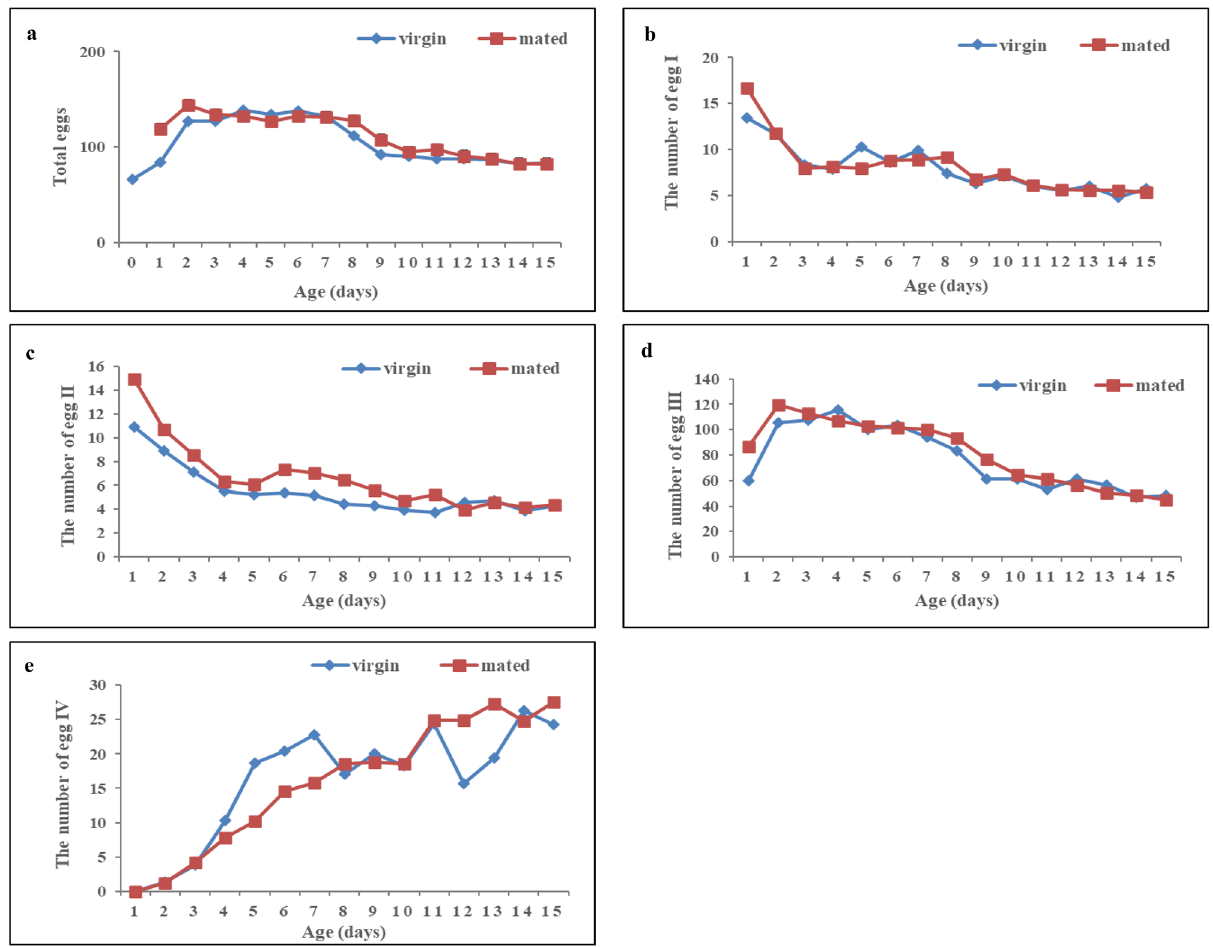
Figure 3. The number of C. japonicus eggs at four egg stages of at different ages. Age: the number of days after the emergence of females.